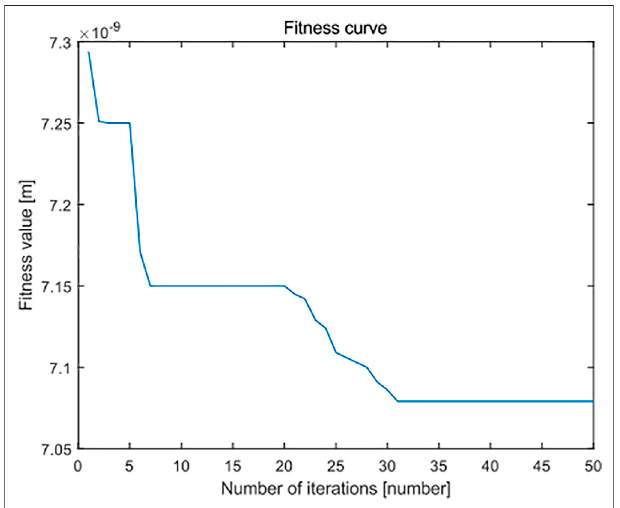
FIGURE 19 | Fitness curve of improved particle swarm optimization algorithm in fl atness error evaluation of the SHS sample of 10 × 10 μ